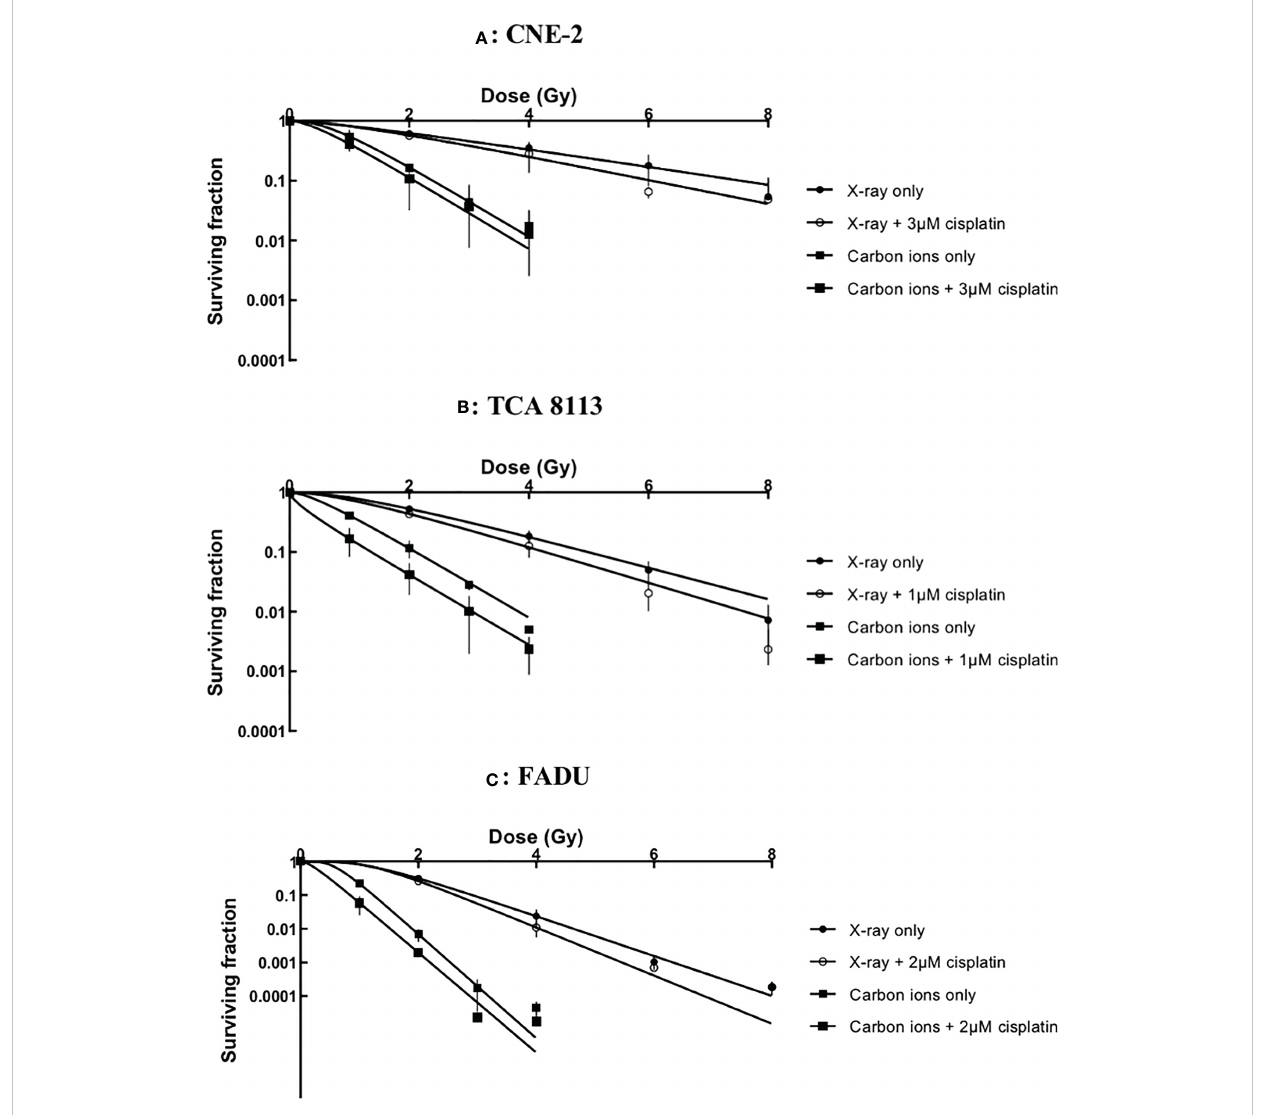
FIGURE 1 Survival curves of chemoradiotherapy experiments in CNE-2 (A) , TCA 8113 (B) and FADU (C) cell lines.